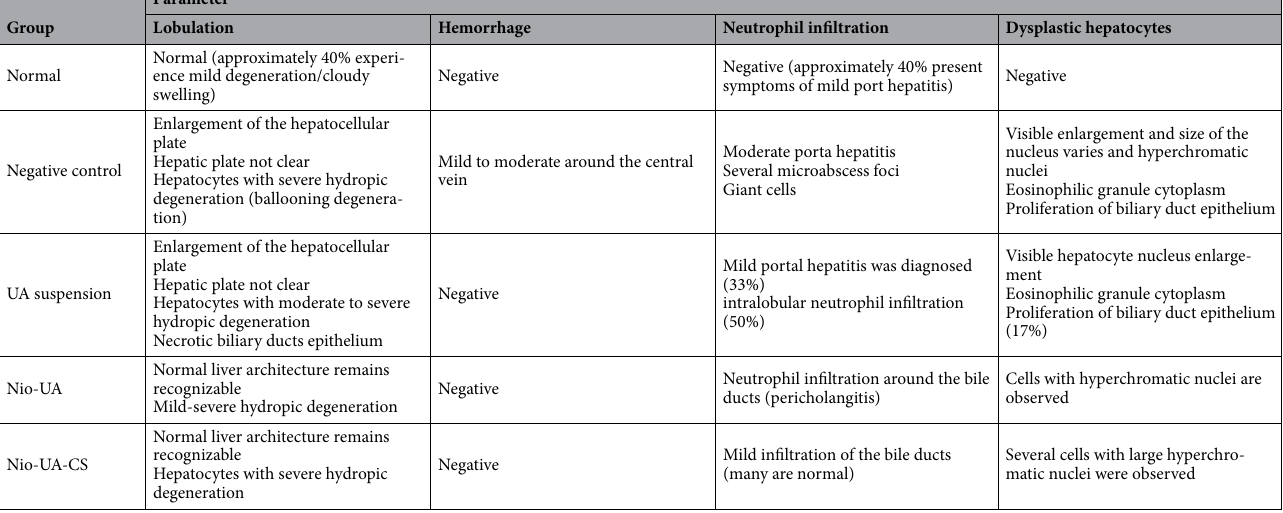
Table 1. Observation of histopathological liver preparations of subjects in the normal group, negative control, suspension of UA, Nio-UA, and Nio-UA-CS equivalent to a dose of 11 mg